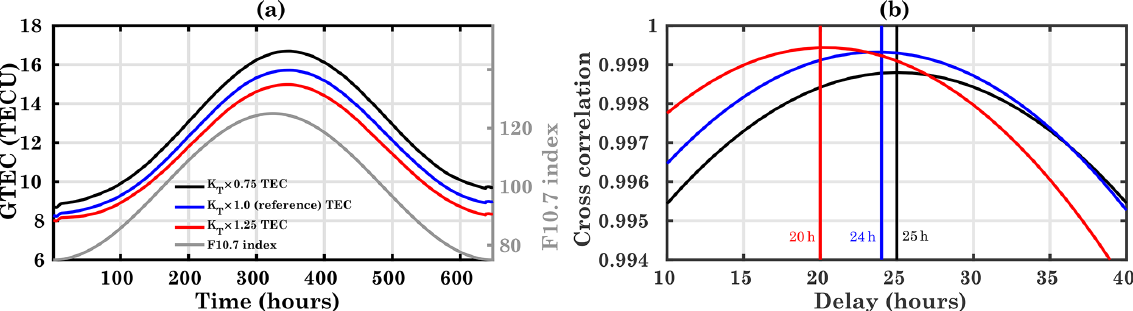
Figure 3. (a) Time series of modeled GTEC for different runs (a) K T × 0 . 75, (b) K T × 1 . 0 (reference), and (c) K T × 1 . 25, together with F10.7 given as a gray line. (b) Cross-correlation and the delay between global mean TEC and F10.7 for the different runs.